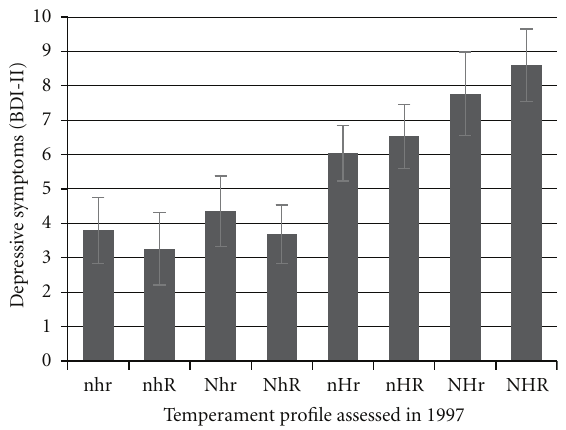
Figure 4: BDI-II depressive symptoms sum scores in di ff erent temperament combinations. Sex and birth year were controlled. NHR = sensitive; NHr = explosive; NhR = passionate; Nhr = adventurous; nHR = cautious; nHr = methodical; nhR = reliable; nhr =